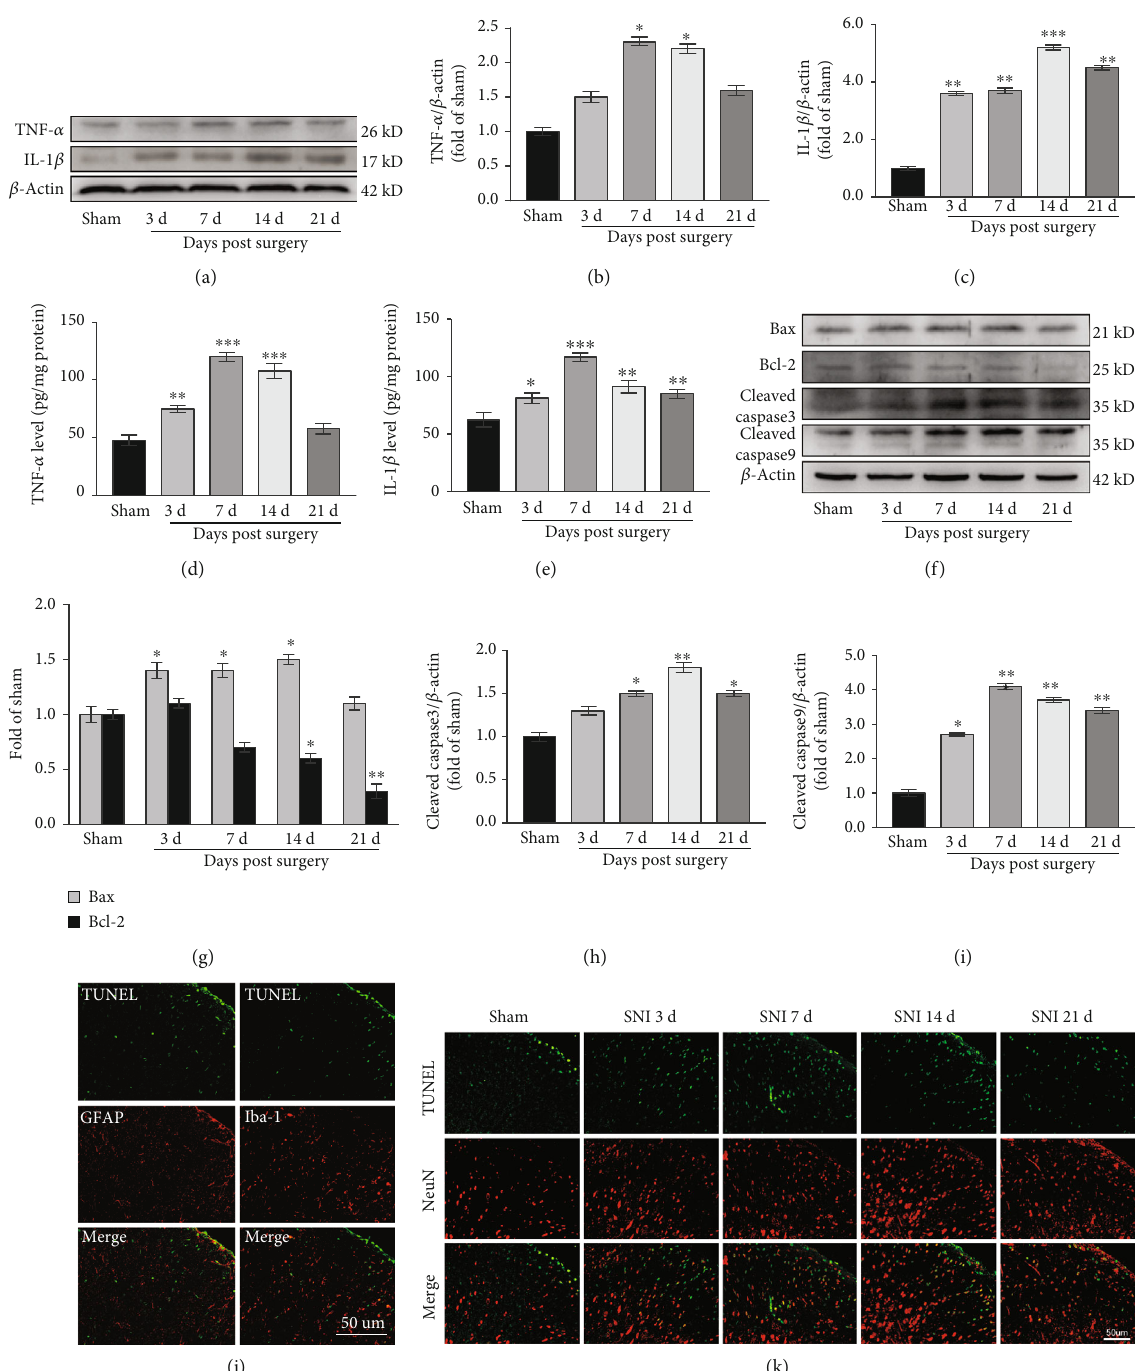
Figure 6: SNI induces in fl ammation and apoptosis in the spinal cord. (a – c) Western blots and quanti fi cation of TNF- α and IL-1 β expression in the spinal cord ( n = 3 ). ∗ P < 0 : 05 , ∗∗ P < 0 : 01 , ∗∗∗ P < 0 : 001 versus Sham group. (d, e) TNF- α (d) and IL-1 β (e) levels in the spinal cord as measured by ELISA ( n = 3 ). ∗ P < 0 : 05 , ∗∗ P < 0 : 01 , ∗∗∗ P < 0 : 001 versus Sham group. (f – i) Western blots and quanti fi cation of bax, bcl-2, caspase3, and caspase9 expression in the spinal cord. ∗ P < 0 : 05 , ∗∗ P < 0 : 01 versus Sham group. (j, k) Double labeling for TUNEL and GFAP, Iba-1, or NeuN. TUNEL-positive cells are mainly colocalized with NeuN (k), a small amount colocalizes with GFAP and Iba-1 (j). TUNEL-positive cells are green, NeuN, GFAP, and Iba-1 are